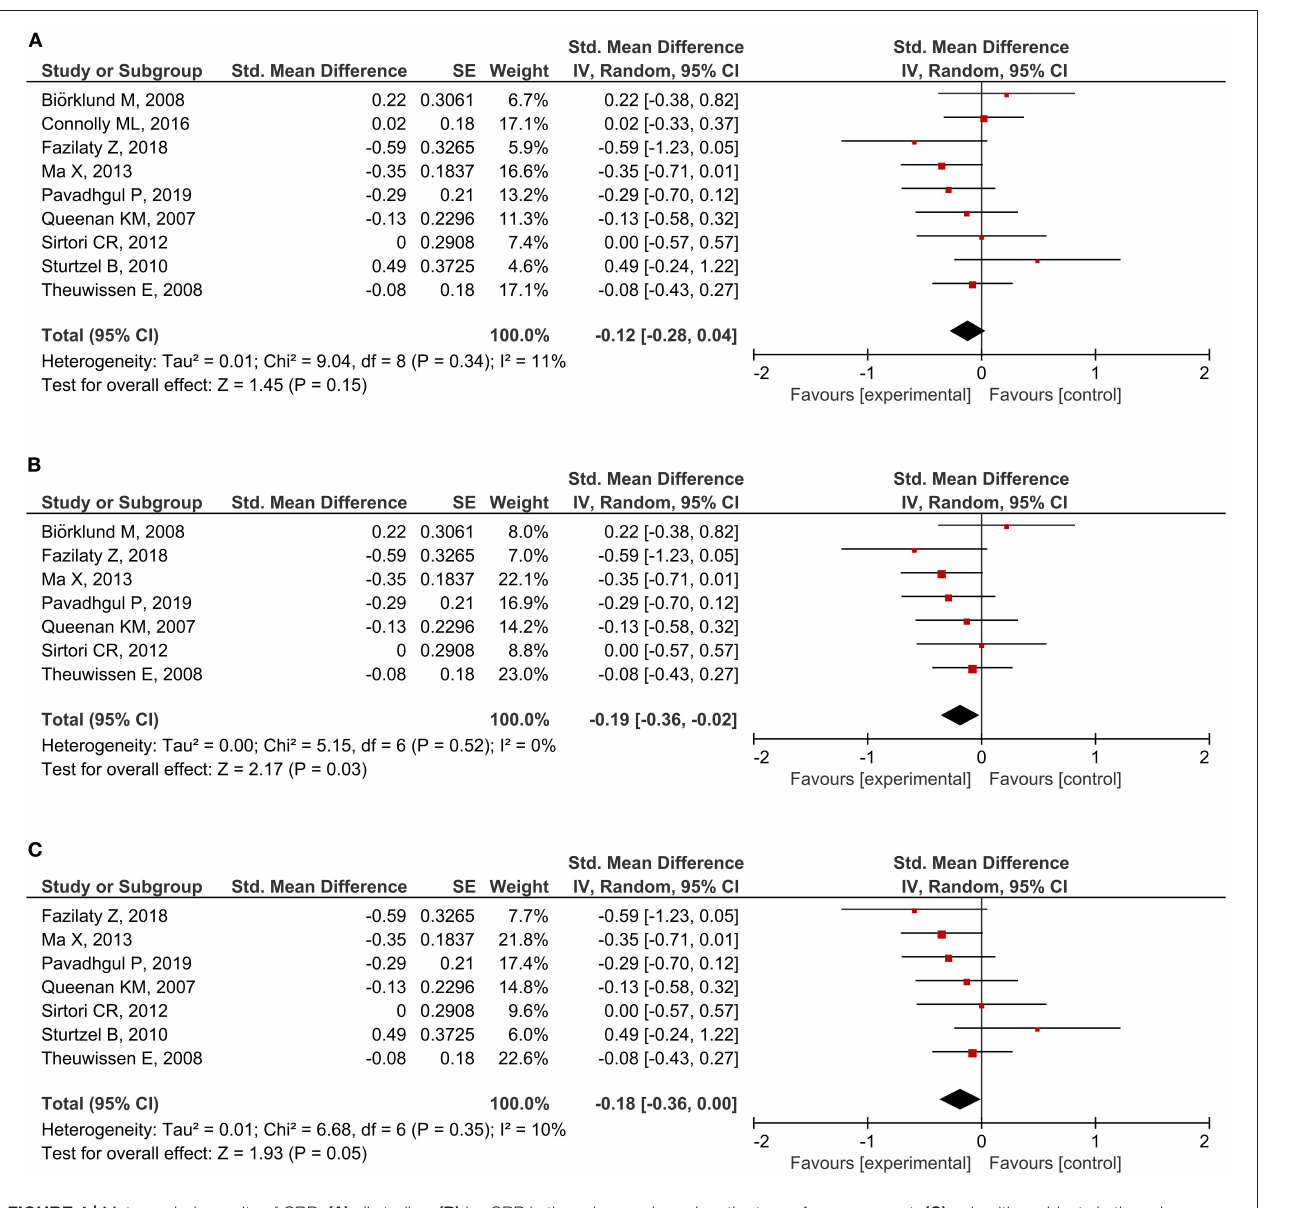
FIGURE 4 | Meta-analysis results of CRP: (A) all studies, (B) hs-CRP in the subgroup based on the type of measurement, (C) unhealthy subjects in the subgroup based on the basal